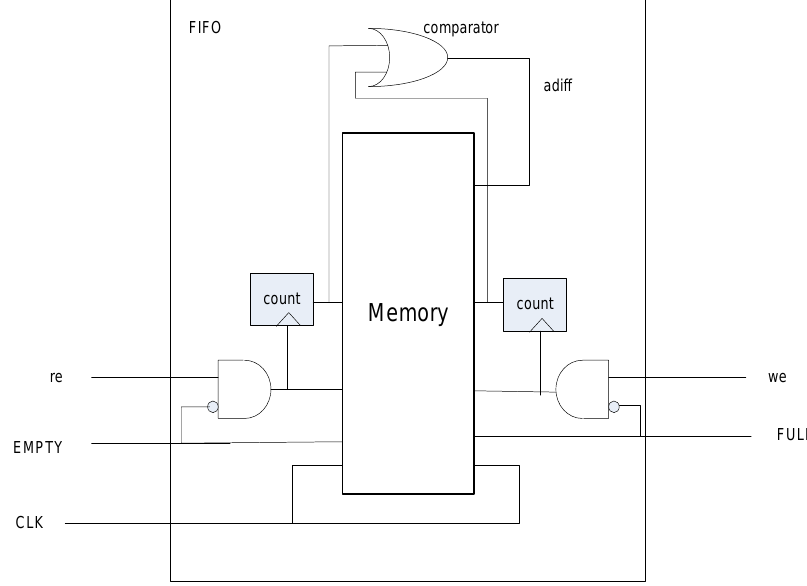
Figure 3. Block diagram of first-in-first-out (FIFO) to store time stamps of radar detect signals.